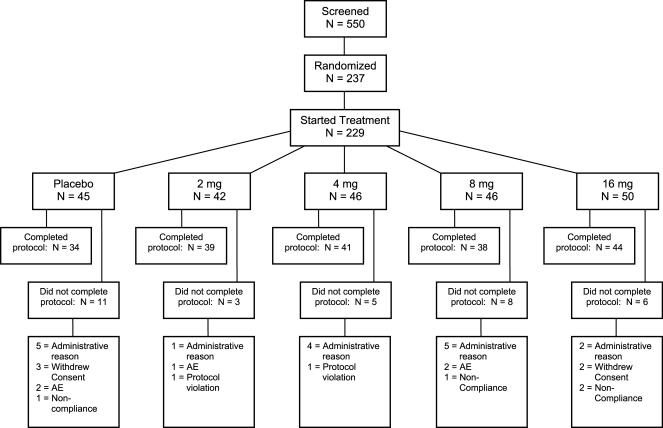
CONSORT Diagram.